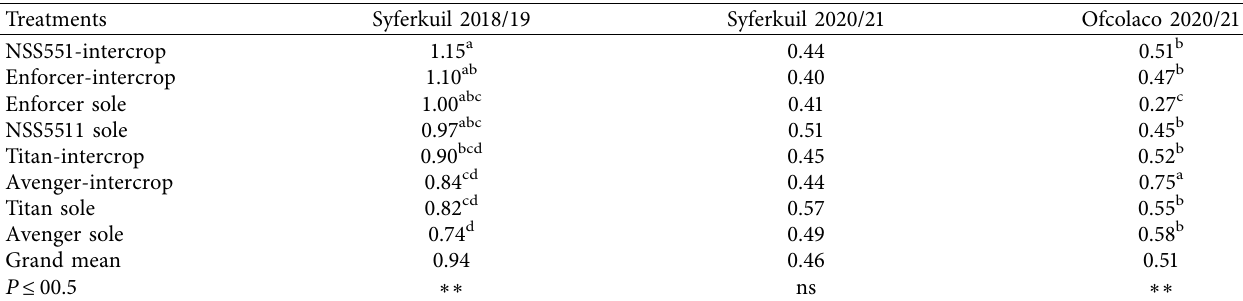
Table 3: Carbon dioxide emission efciency (CEE) of sorghum in intercrop and sole systems at Syferkuil and Ofcolaco during the 2018/19 and 2020/21 cropping seasons.